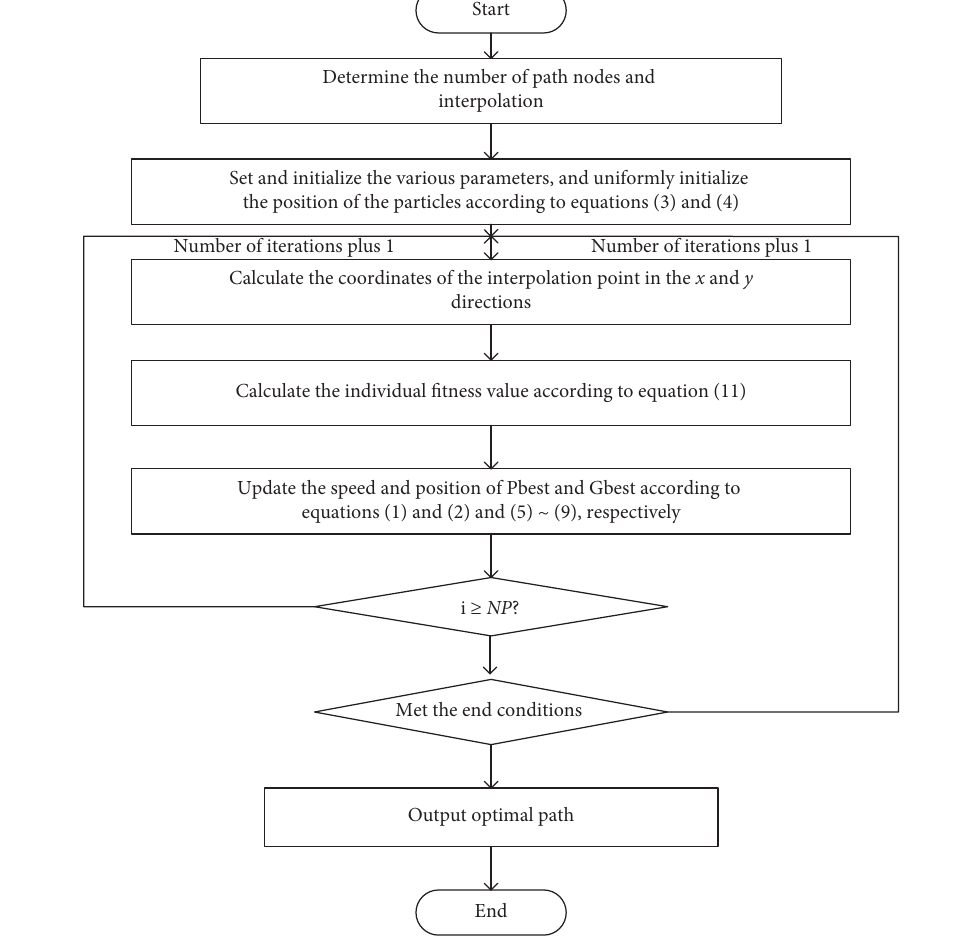
Figure 1: Flowchart of improved PSO algorithm. Table 1: Standard test